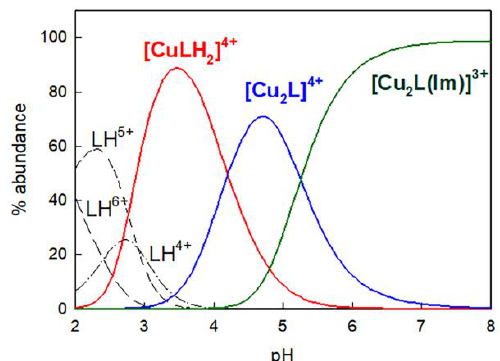
Figure 1. Distribution diagram obtained for aqueous solutions containing Cu(II), BPXD (indicated as L) and imidazole in 2:1:1 molar ratio ([BPXD] = [ImH] = 5 × 10 − 4 M, [Cu(CF 3 SO 3 ) 2 ] = 1 × 10 − 3 M in 0.05 M CF 3 SO 3 Na, T = 25 °C).